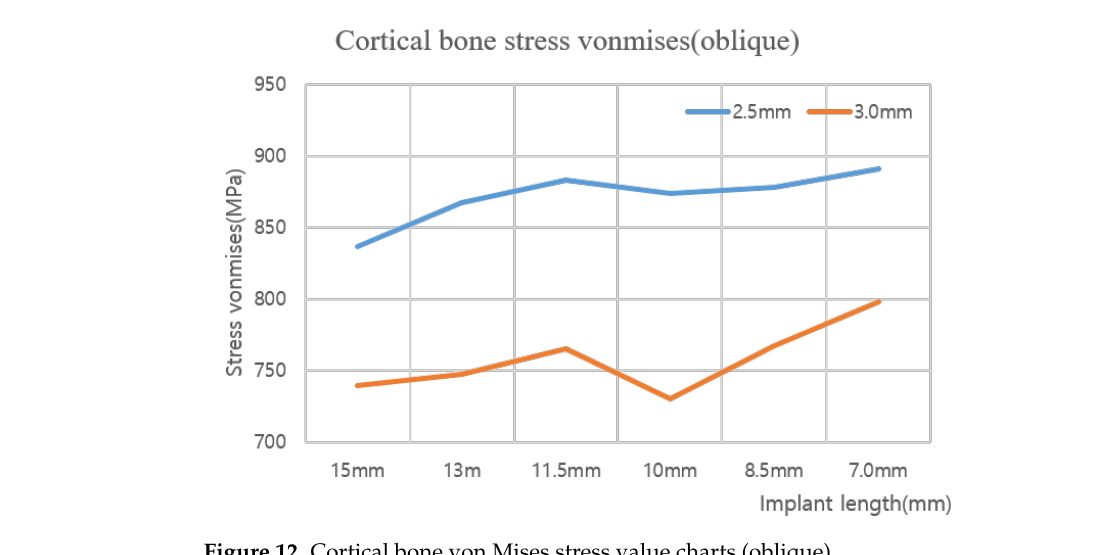
Figure 12. Cortical bone von Mises stress value charts